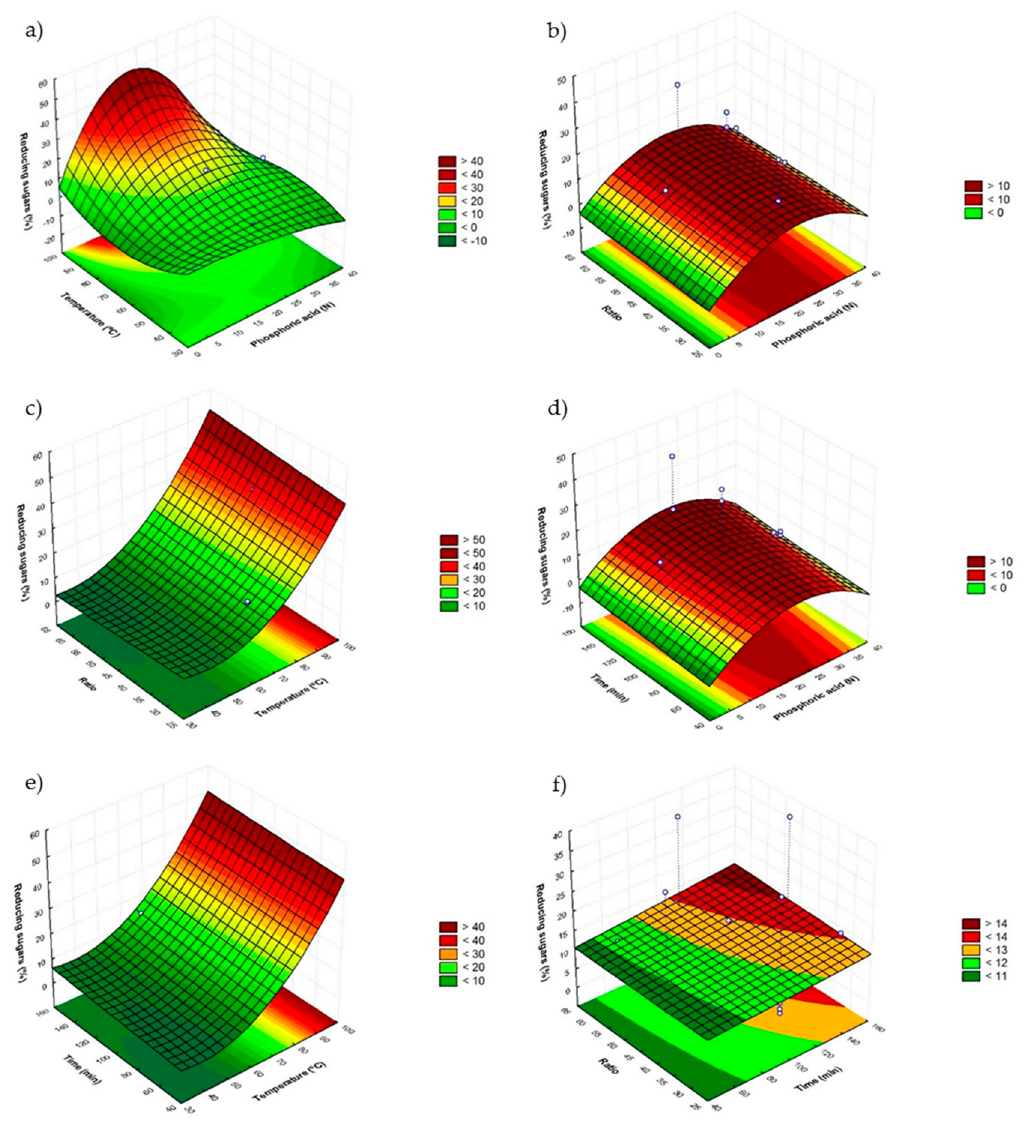
Figure 2. Response surface graphs ( a – f ) showing the combined effects of the process variables: H 3 PO 4 concentration (N), temperature ( ◦ C), time (min) and ratio (H 3 PO 4 / sample). Concluding, the optimal conditions are: H 3 PO 4 21 N, 90 C, 60 min and 60 mL / g